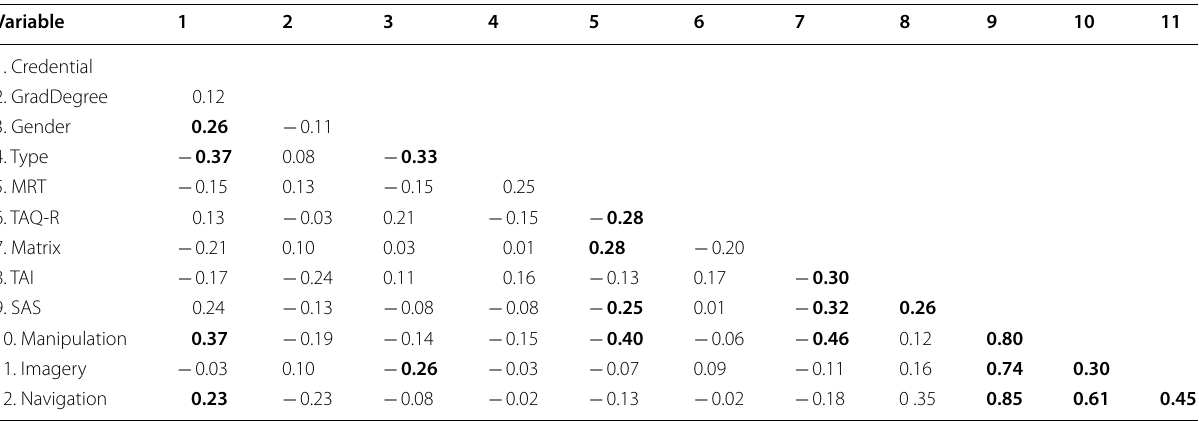
Table 4 Correlational data among all examined variables